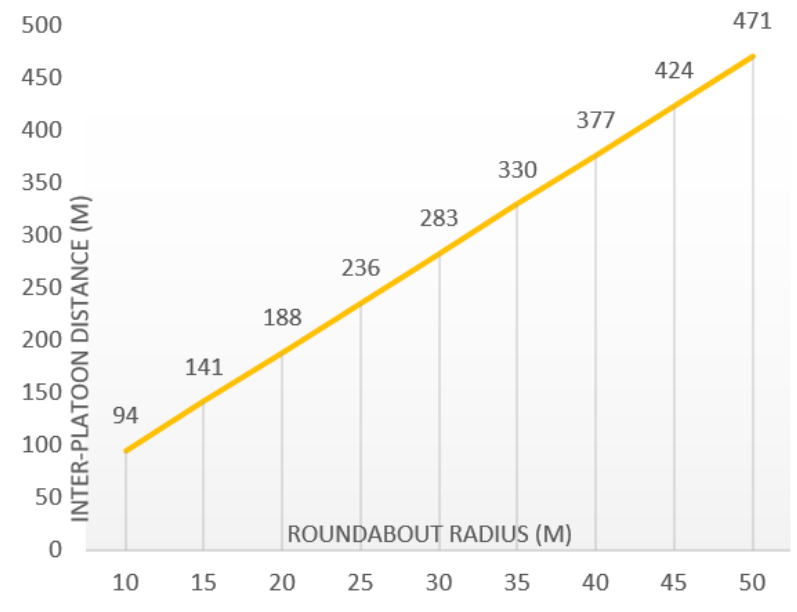
Figure 21. Inter-platoon distances versus roundabout